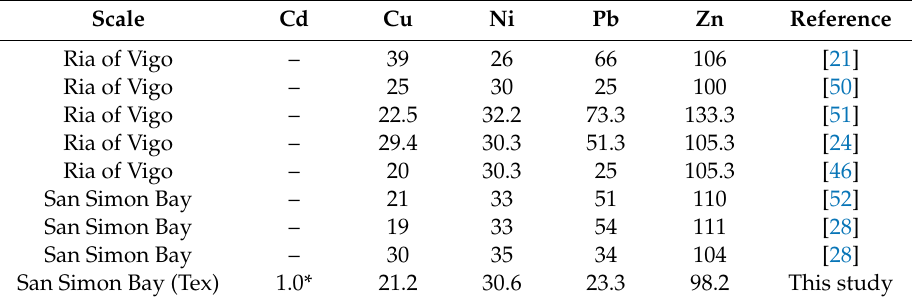
Table 1. Local background [Me] BG levels for trace elements (mg kg − 1